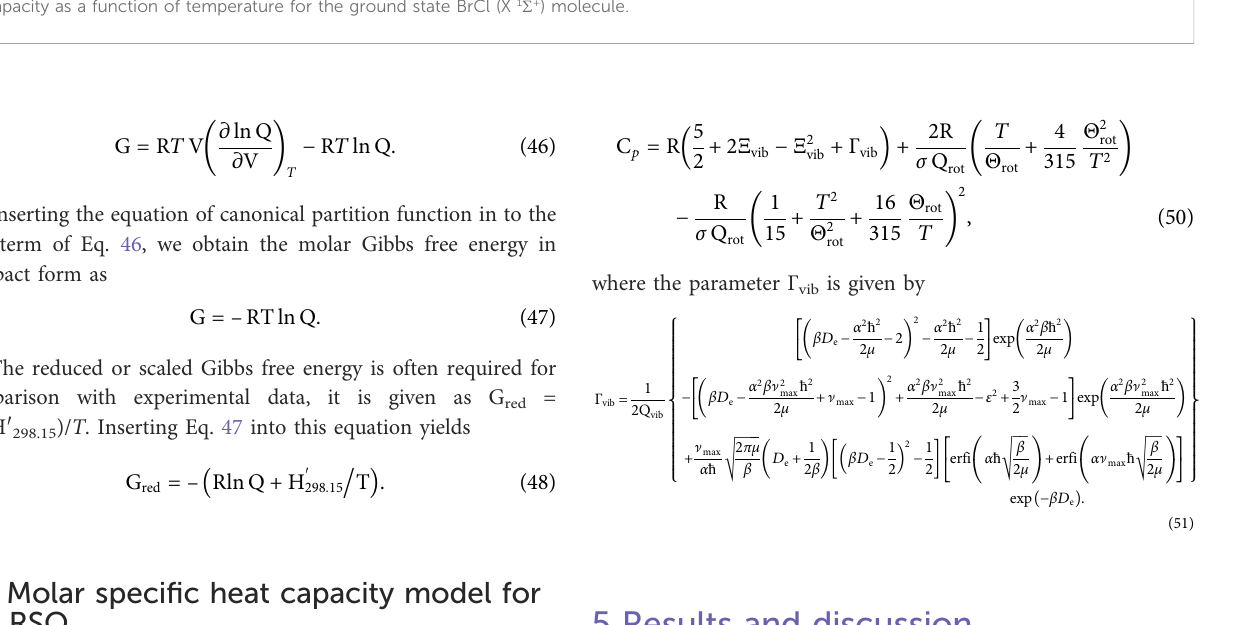
FIGURE 5 Variationof (A) molarentropy(Jmol − 1 K − 1 ), (B) reducedenthalpy (kJmol − 1 ), (C) reducedGibbsfreeenergy(J mol − 1 K − 1 ),and (D) isobaric speci fi cheat capacity as a function of temperature for the ground state BrCl (X 1 Σ + )